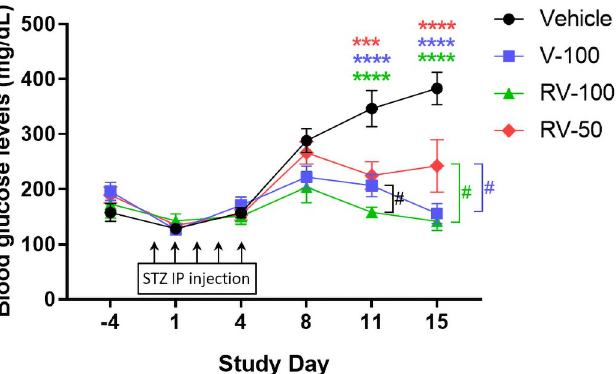
Fig 4. Fasting BG of STZ-induced mice treated with Verapamil (V) and R-Vera (RV) from days 6–15. Relative BG improved for the racemic and R-Vera groups. Bars are means ± SD. N = 8 mice per vehicle, V-100, RV-100, and RV-50 groups. ��� P < 0.001, ���� P < 0.0001, significant difference from vehicle, using two-way ANOVA with Tukey’s multiple comparison; # P < 0.05, significant difference between V-100 and RV-100 on day 11 and between V-100 or RV-100 and RV-50 on day 15, using an unpaired student’s t